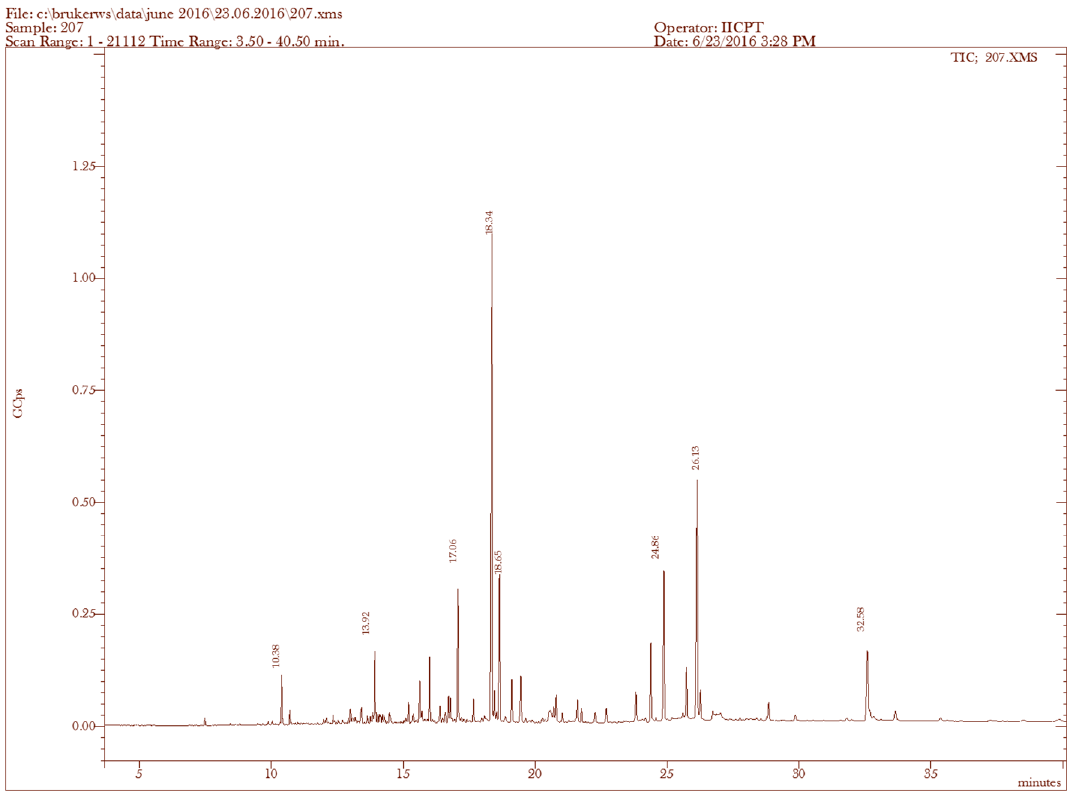
Figure 2. GC–MS/MS chromatogram formed by ethanolic fractions of Laurencia paniculata . The